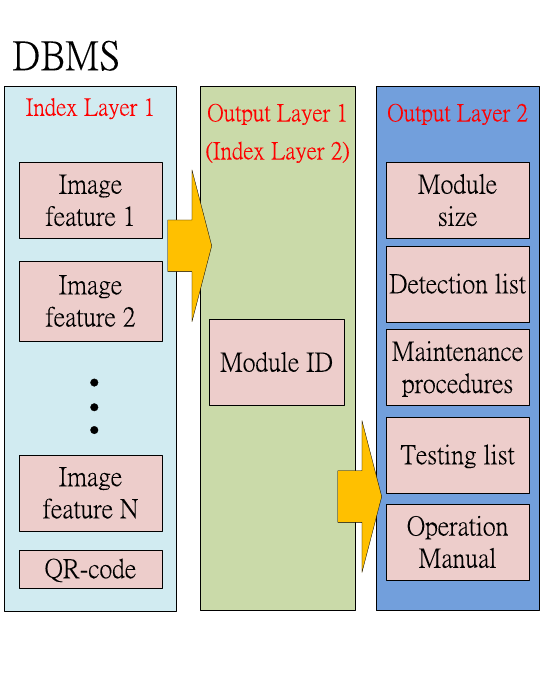
Figure 3. The DBMS architecture.